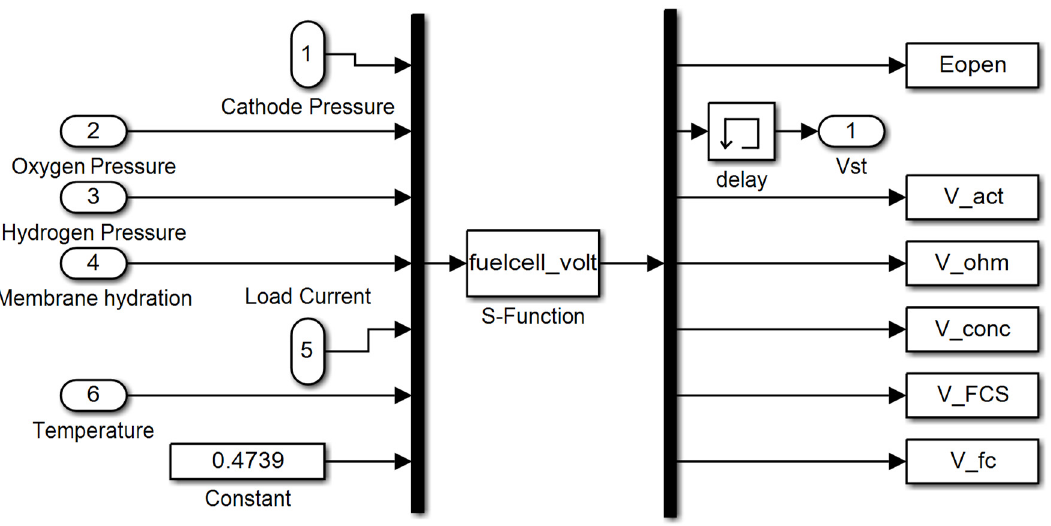
Figure 2. Display of FC model developed using S-Function.